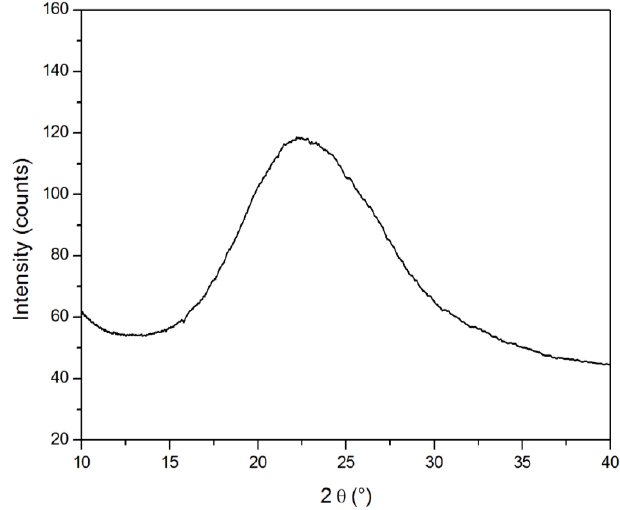
Figure 10. XRD pattern of Hyb-H-B obtained after its burn out at 500 °C.